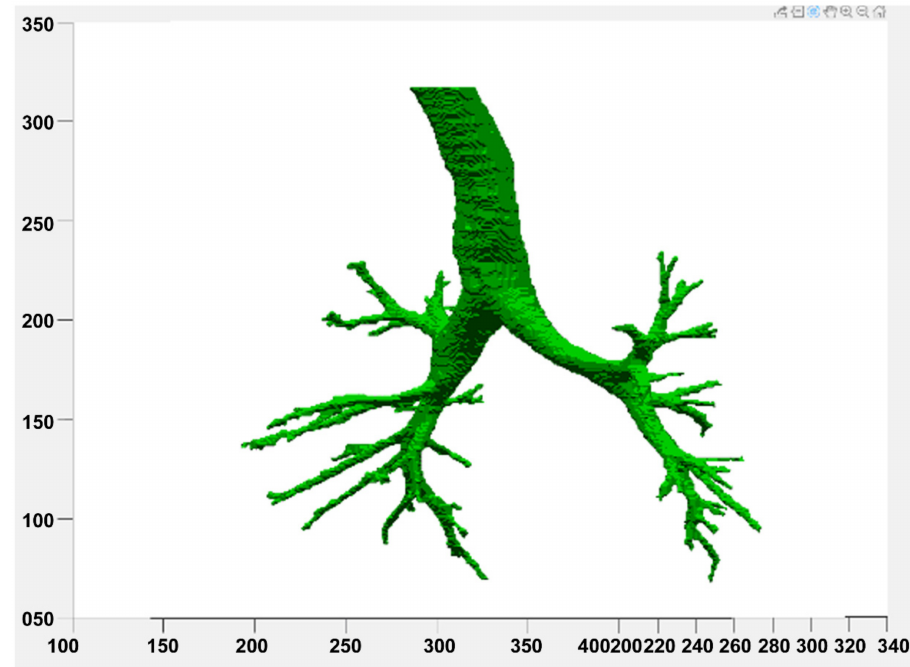
Figure 7. 3D reviewed pulmonary airway extraction